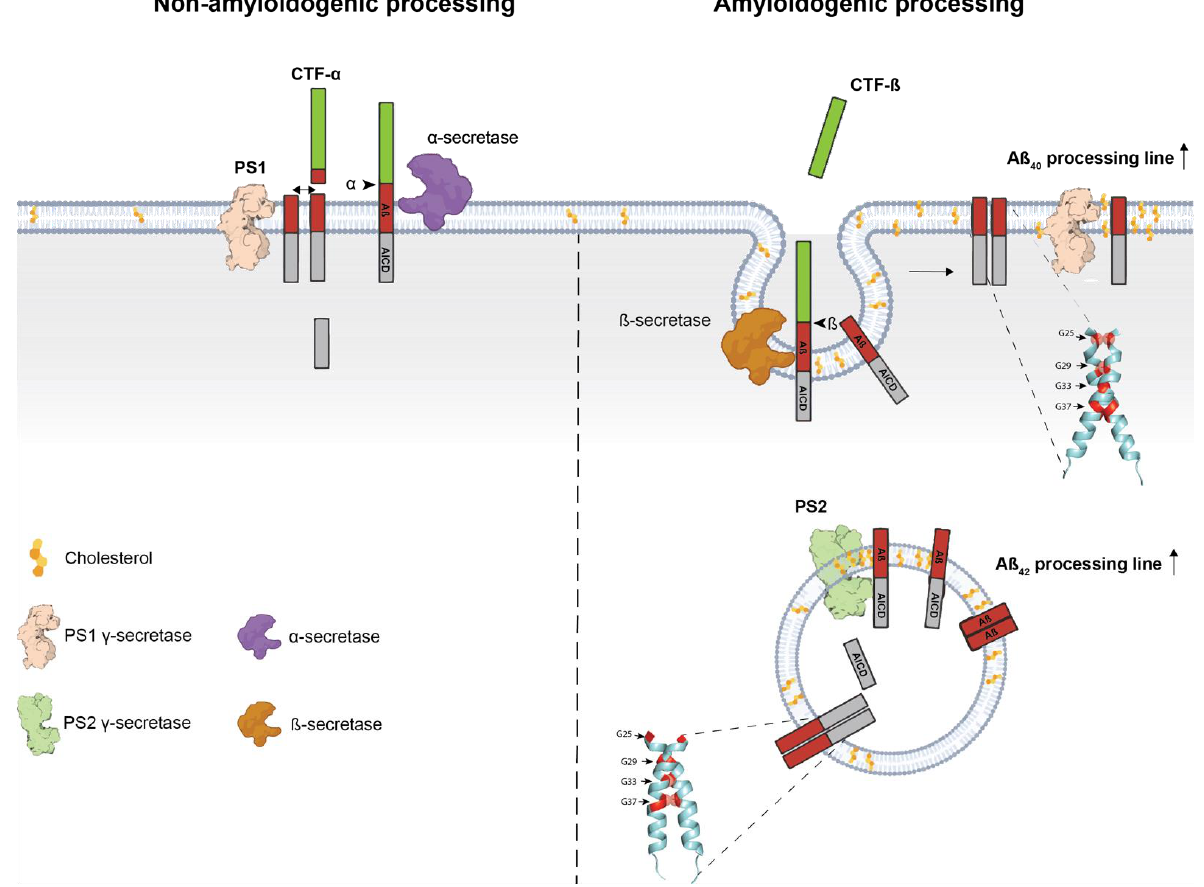
Figure 4. The role of C99 dimerization in Aβ generation . Illustration of the role of C99 dimerization, cholesterol concentration, and PSs localization on APP /C99 processing and Aβ generation. In- itial cleavage by α - or β -secretase occurs at the plasma membrane or in endosomes, respectively. In addition, low cholesterol concentration favors α -cleavage while high cholesterol content is associated with β -cleavage. After initial cleavage, γ -secretase cleavage can occur either at the cell surface (preferably by PS1) or in endosomes (preferably by PS2). One hypothesis is that medium cholesterol concentration favors dimerization in one of the two dimeric orientations with either 25 GxxxG 29 or 33 GxxxG 37 motifs in the interface. Such dimeric concentration targets C99 either to endosomes ( 33 GxxxG 37 interface) or to the cell surface ( 5 GxxxG 29 interface). When concentration of cholesterol increases (such as in lipid rafts), dimerization is destabilized to allow processing by PS1- or PS2- dependent γ -secretase.